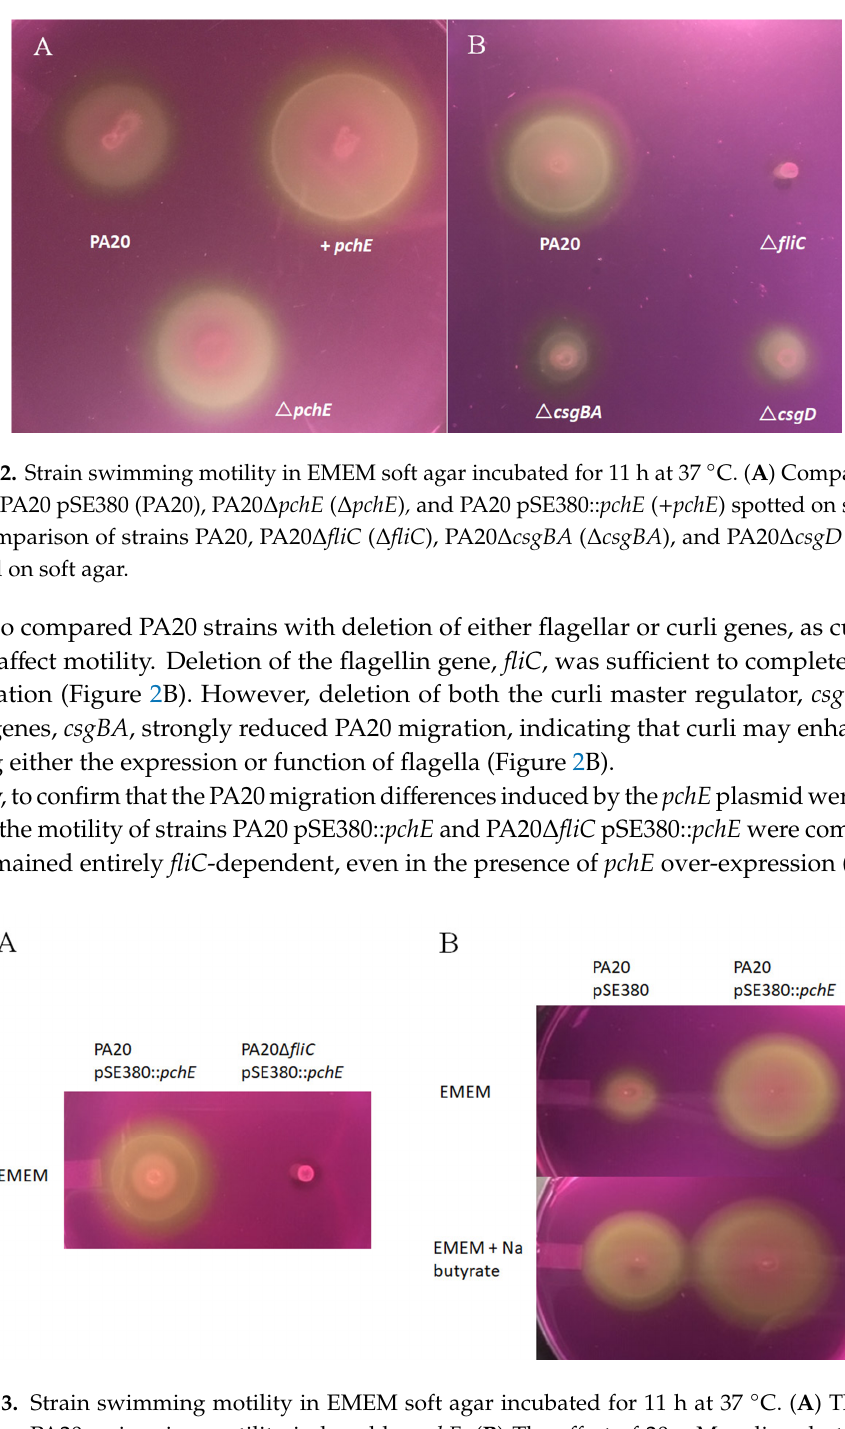
Figure 3. Strain swimming motility in EMEM soft agar incubated for 11 h at 37 °C. ( A ) The effect of fliC on PA20 swimming motility induced by pchE. ( B ) The effect of 20 mM sodium butyrate on strain